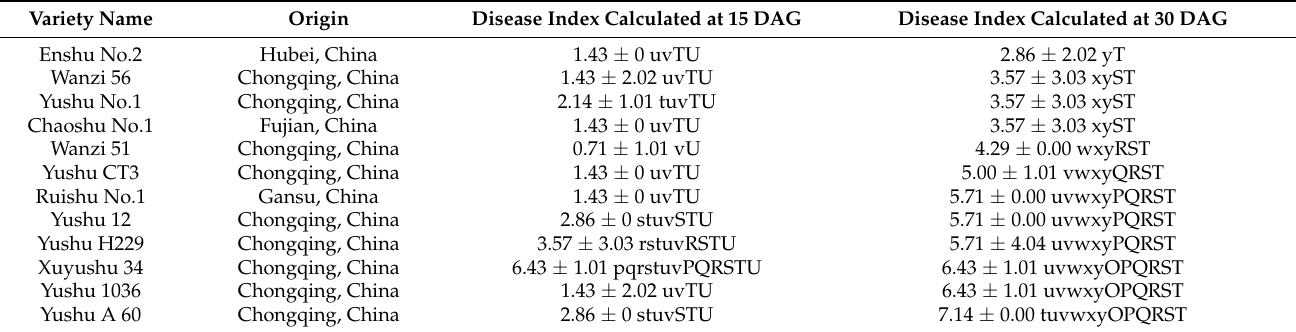
Table 1. Disease indexes of 86 sweet potato varieties after inoculation of sweet potato virus disease (SPVD) using grafting in 2016.